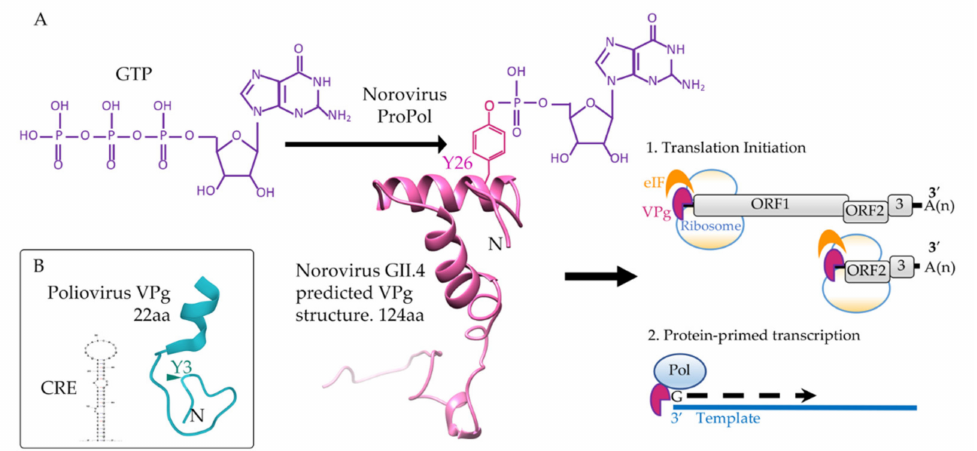
Figure 2. Guanylylation of a calicivirus VPg. ( A ) For the nucleotidylylation reaction, ProPol catalyzes a nucleophilic attack by the hydroxyl of Y26 of VPg (pink) on the alpha phosphate of GTP (purple). This produces a phosphodiester bond covalently linking GMP onto Y26 of VPg. Guanylylated human norovirus VPg functions to recruit host eukaryotic initiation factors (eIF) for translation and interacts with Pol or ProPol to stimulate protein-primed transcription of the RNA genome. Structural predictions for human norovirus GII.4 VPg (KY905331) were performed with Phyre and imaged with Chimera [33,34]. ( B ) In addition to polymerase, a CRE RNA (AY184219) is required for nucleotidylylation of the poliovirus VPg (blue) on tyrosine 3 (Y3). The poliovirus 1 VPg structure (2BBL) was obtained from PDB and the representation of the CRE RNA stem-loop predicted using mFold [35]. Nucleotidylylation of poliovirus VPg does not contribute to translation initiation, only protein-primed transcription. Amino acid (aa) length of the VPg proteins is